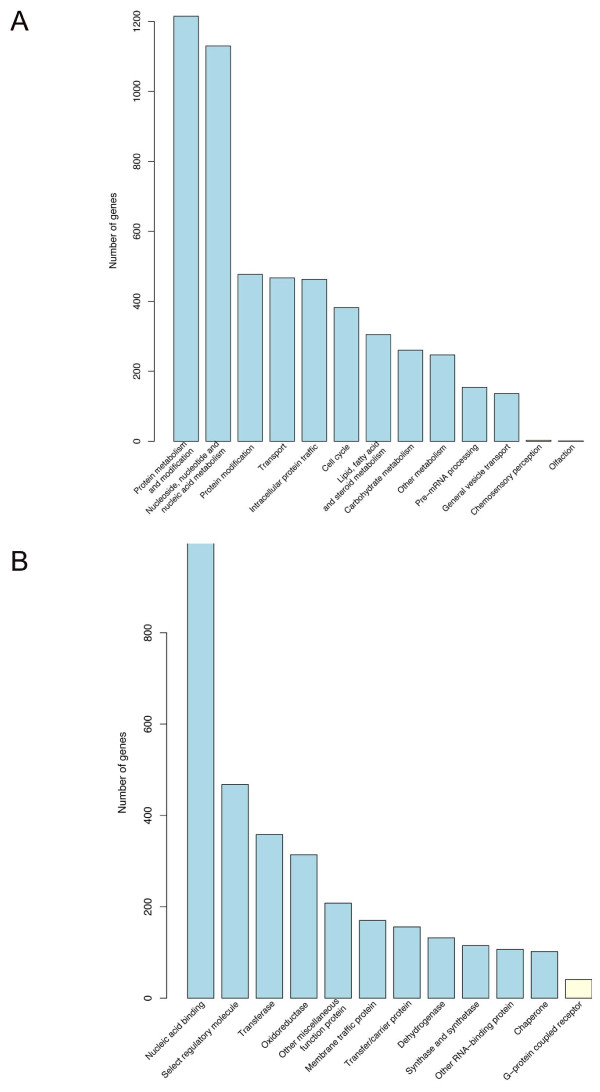
Enrichment analysis of GO annotations in bear genes. (A) Genes that were over- or under-represented in biological processes terms. (B) Genes that were over- or under-represented in molecular function terms. Both biological processes and molecular functions were selected with the criteria of P-value ≤ 1.0 × 10-10. Blue bar represents the over-represented process and yellow bar represents the under-represented process.